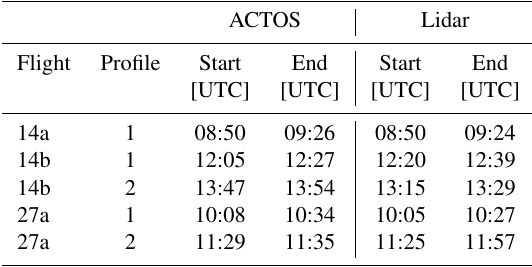
Table 4. Overview of start and end time of the profiles conducted during the flights 14a, 14b, and 27a. Also the averaging period for the respective lidar profiles is given.